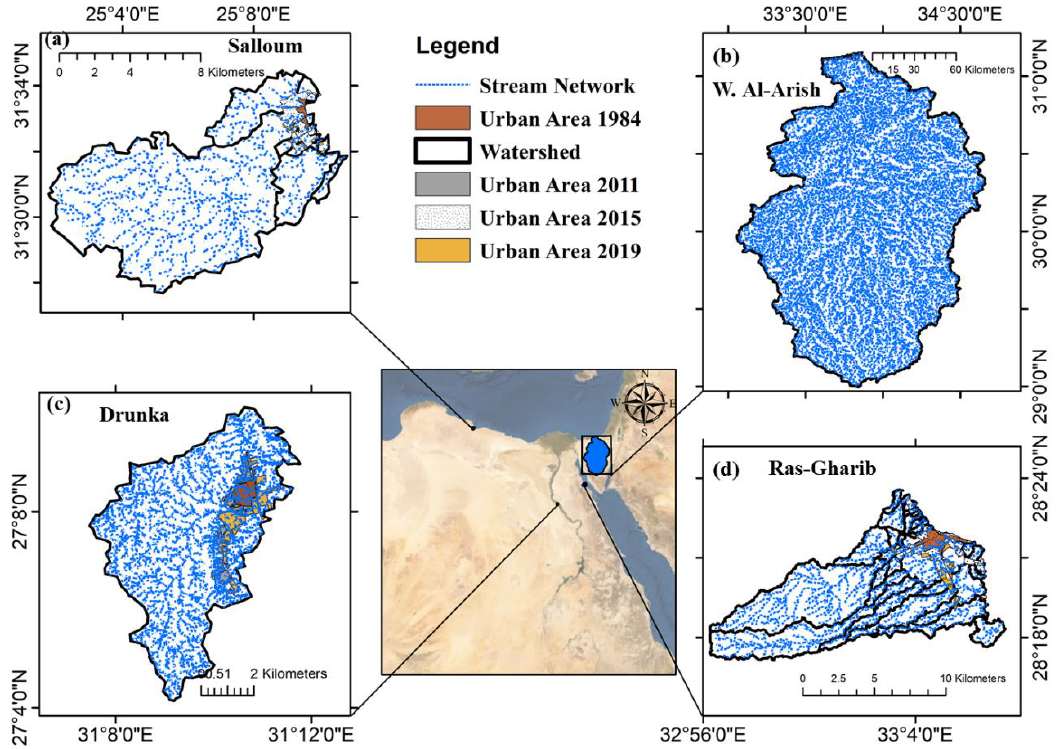
Figure 4. Location maps showing the target cities and related wadi catchments and stream network developed from the digital elevation model (DEM) (Sentinel-2) by GIS: ( a ) Salloum, ( b ) Wadi Al-Arish, ( c ) Drunka, and ( d ) Ras Gharib .